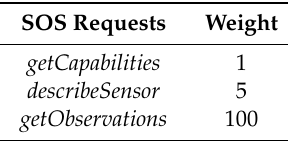
Table 3. Relative weights of Sensor Observation Service (SOS) requests used for the data consumer user type during the test’s execution.